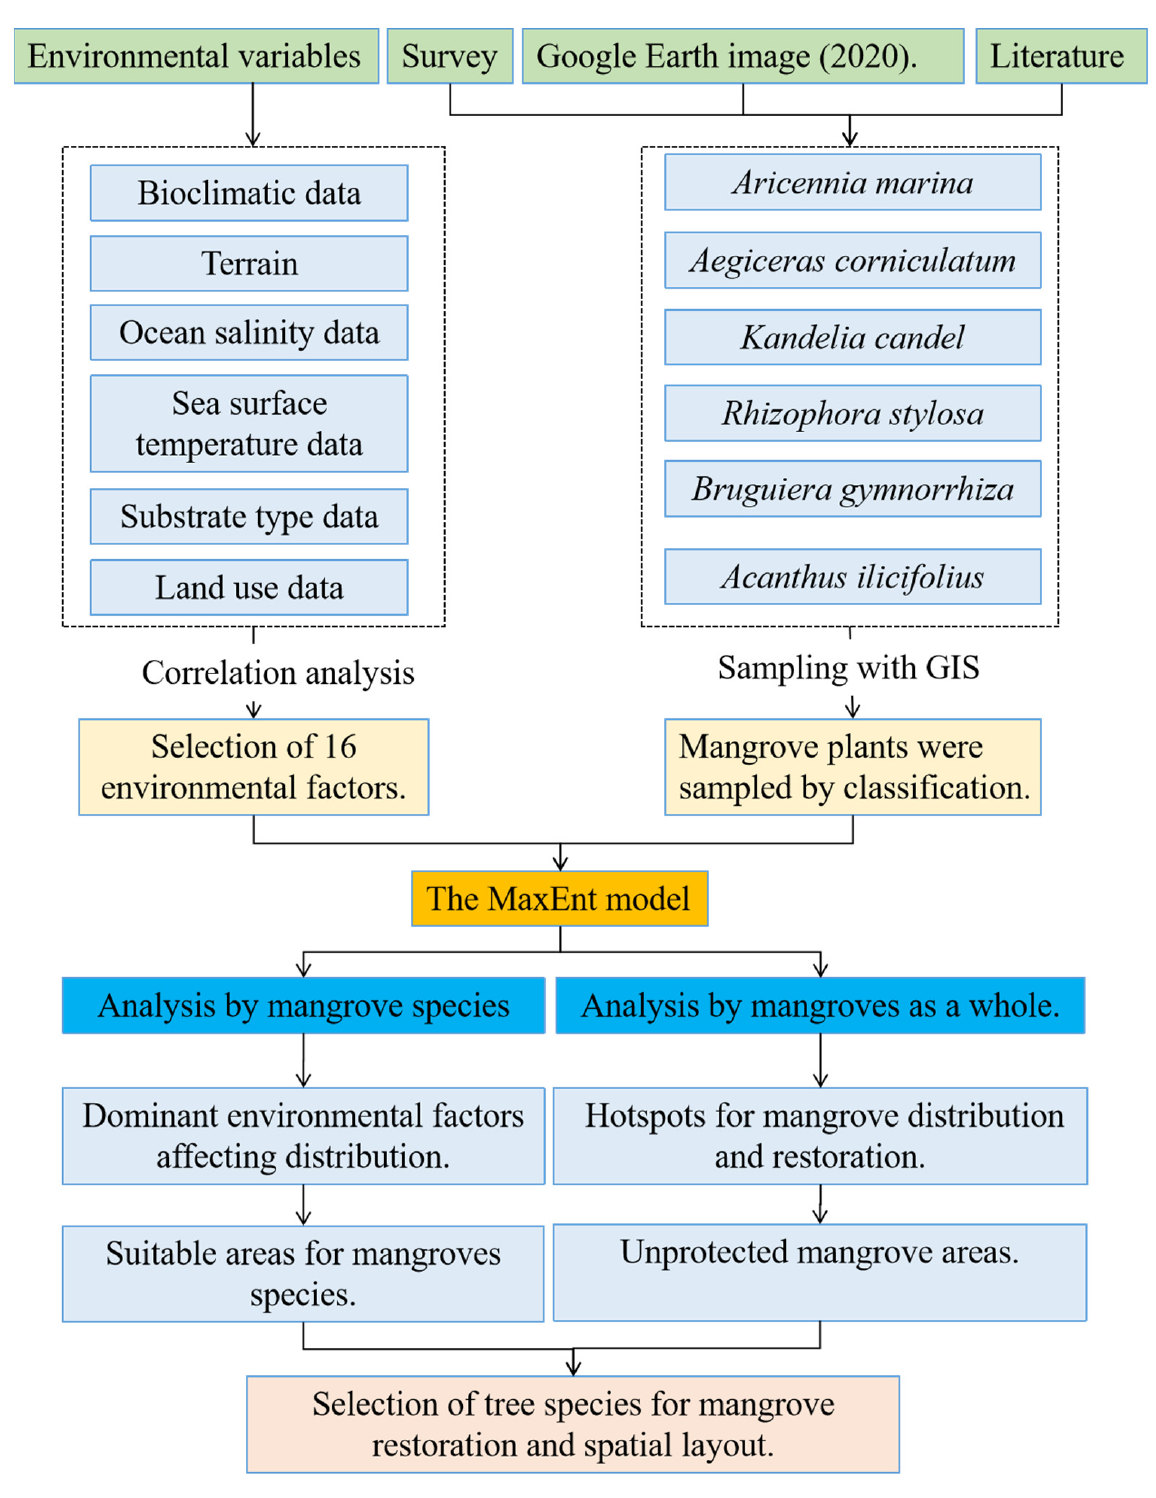
Figure 2. The analytical framework used to predict potential mangrove species distributions for restoration purposes.